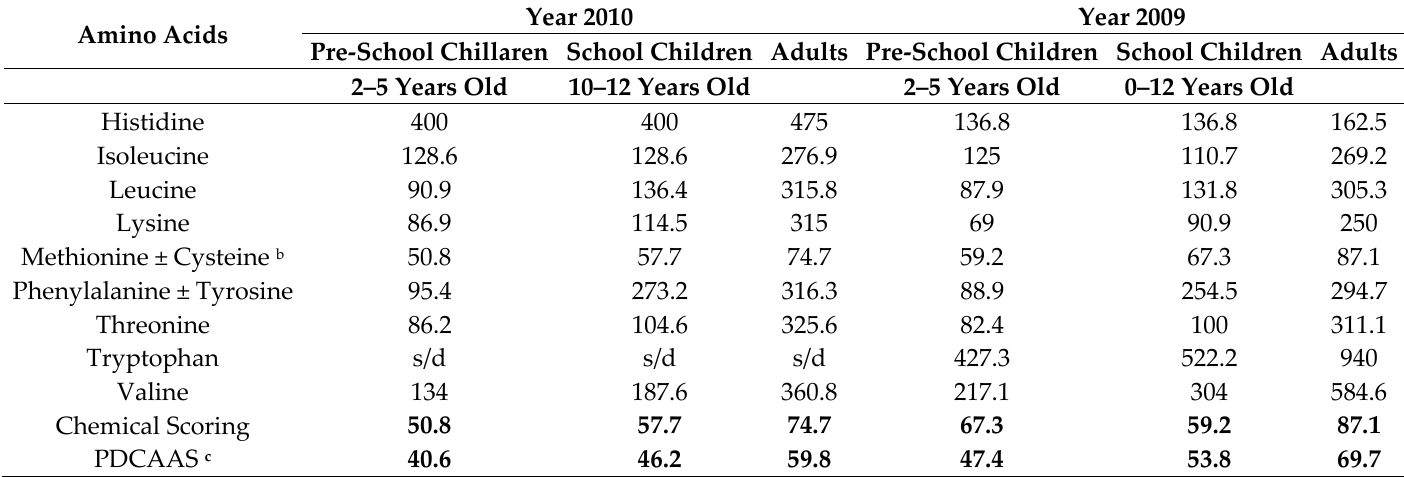
Table 3. Chemical Scoring (CS) a and protein digestibility corrected amino acid score (PDCAAS) of quinoa protein. Amino